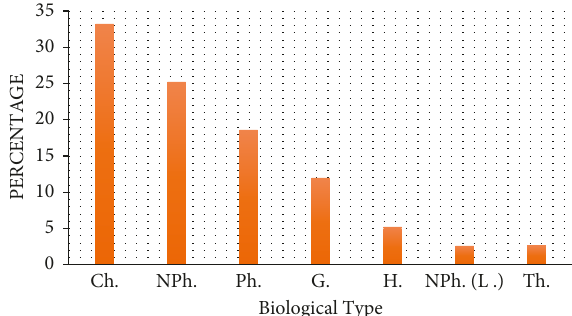
Figure 3: Biological type of medicinal species of the Bigoudine watershed. Ch: Chamaephytes; NPh: nanophanerophytes; Ph: phanerophytes; G: geophytes; H: Hemicryptophytes; Nph (L.): Lianas; Th: